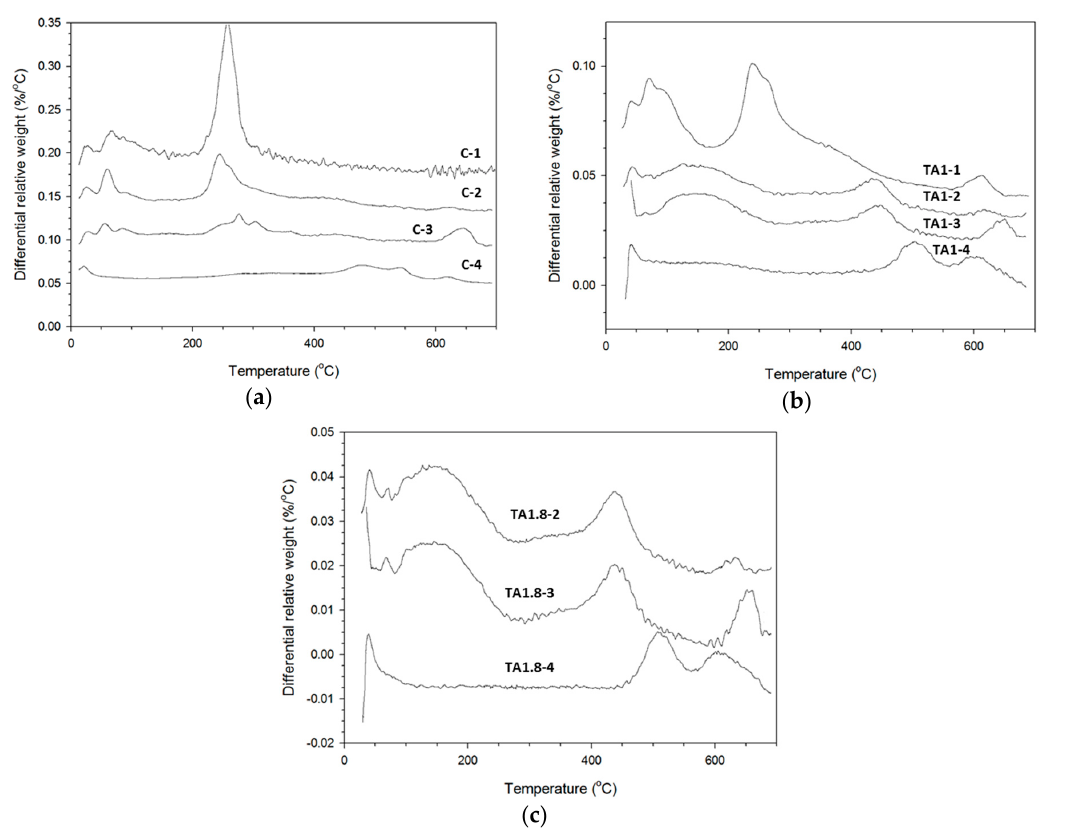
Figure 8. Differential thermal gravimetric analyses (DTG) of TSRC control ( a ) specimens and specimens with ( b ) 1%; and ( c ) 1.8% tartaric acid.